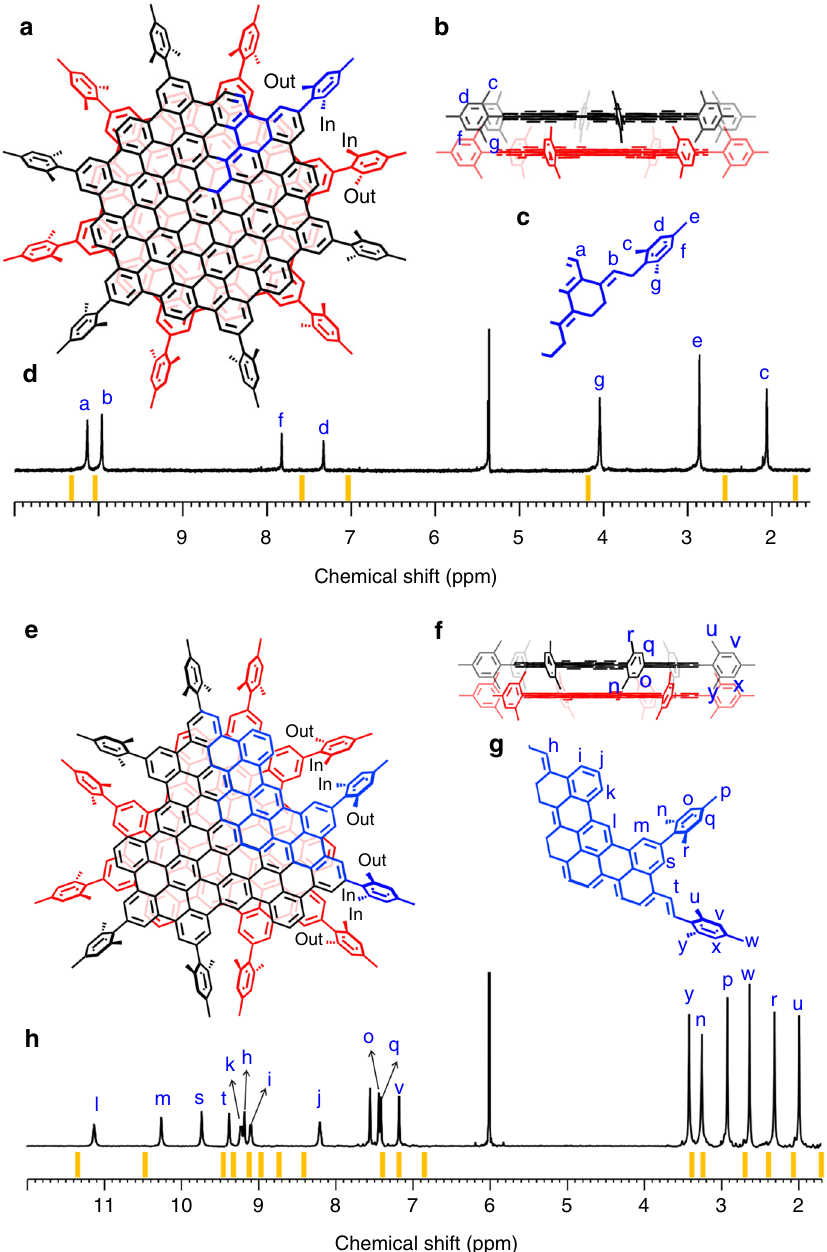
Fig. 2 Nuclear magnetic resonance (NMR) characterization of molecular bilayer graphene. a , e The top views of 1 and 2 , respectively. The asymmetric units in 1 and 2 are highlighted in blue. In and out represents the inward-spacing and outward-spacing methyl of the mesityl group. b , f The side views of 1 and 2 . c , g Numeration of hydrogen atoms in the asymmetric units of 1 and 2 , respectively. d , h 1 H NMR spectra of 1 and 2 . The theoretical NMR spectra of 1 and 2 are represented as orange lines. All of the proton resonances are assigned with the assistance of two-dimensional NMR spectroscopy